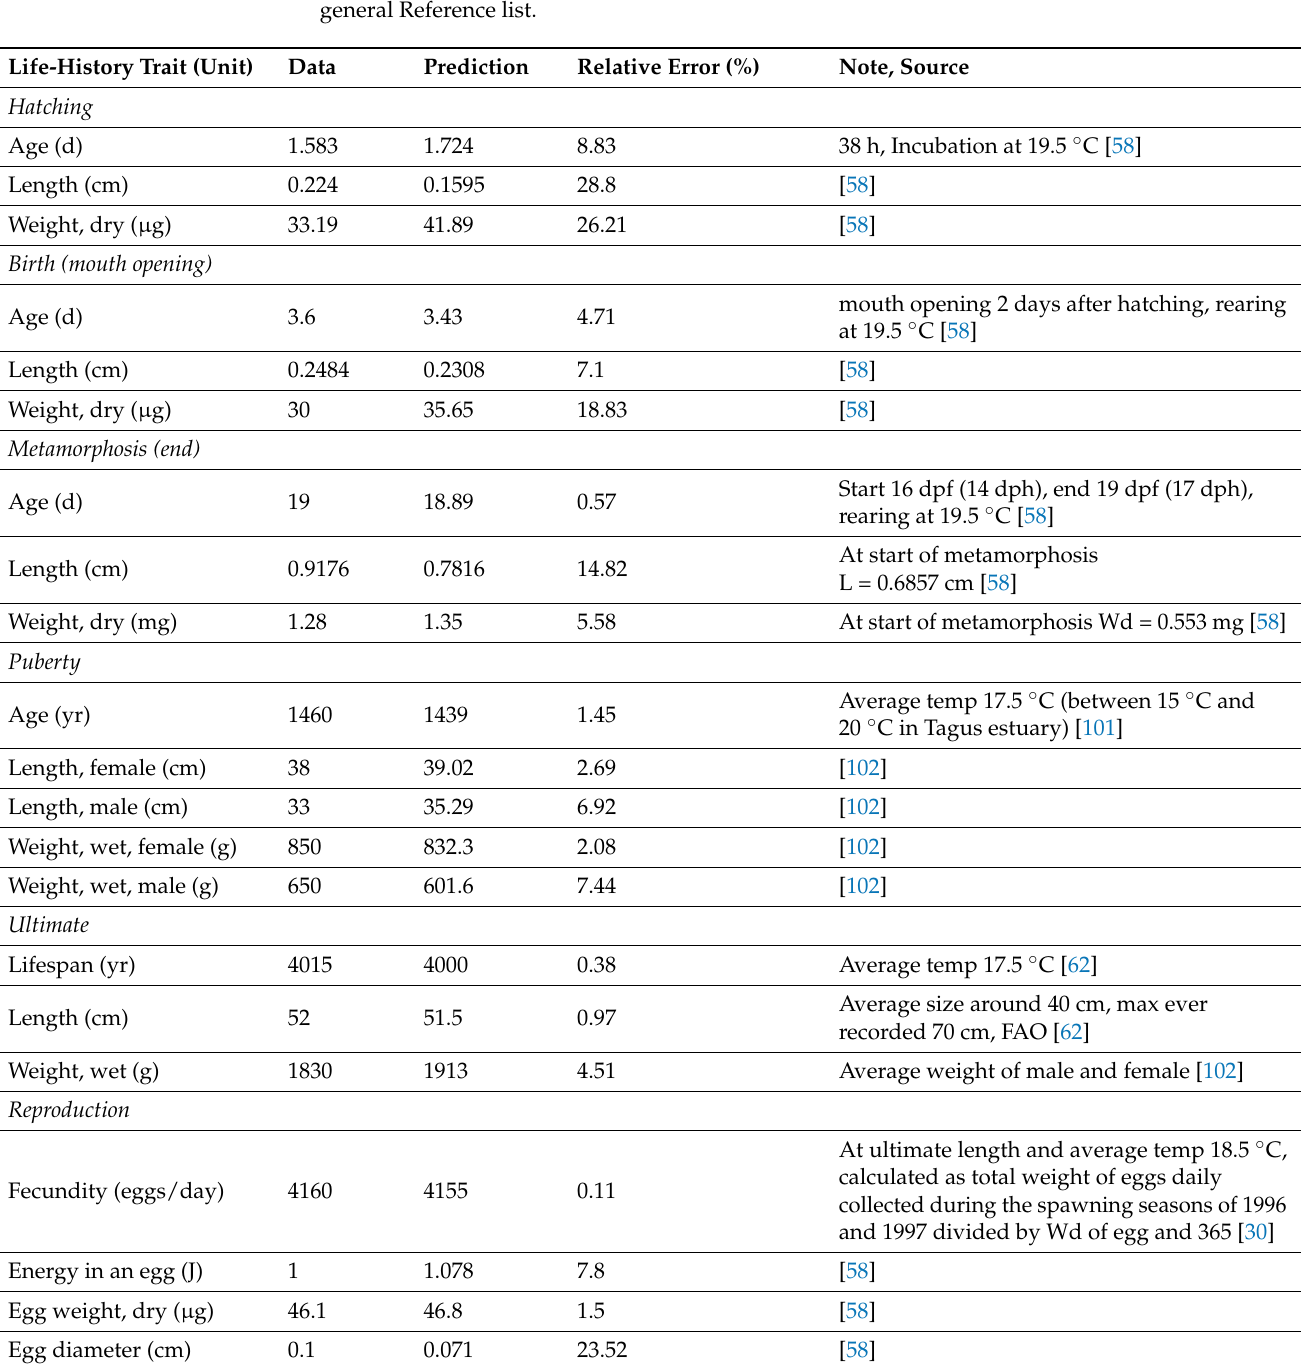
Table A6. Life-history traits (‘zero-variate data’) of Senegalese sole ( S. senegalensis ) used for model parameterization, with corresponding sources, model predictions, and relative errors. Life-history traits are grouped into life stages; ‘Birth’ is defined in DEB as ‘onset of feeding’, and thus corresponds with mouth opening of sole larvae. Definitions of age : ‘Age at hatching’ corresponds to incubation duration (from fertilization until hatching); ‘Age at birth’ corresponds to days needed from fertilization until mouth opening, and ‘Age at metamorphosis’ corresponds to time elapsed between birth (mouth opening) and end of metamorphosis. When relevant, temperatures are listed in the last column under Notes. Unless otherwise specified, the scaled functional response f for certain life-history traits matches that for corresponding datasets. References for sources (in square brackets) are listed in the general Reference